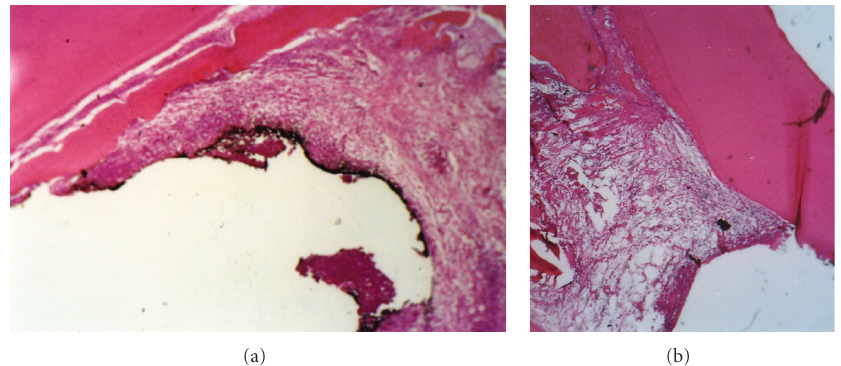
Figure 5: Periodontal tissue response in the dog following a 3- (a) or 8- (b) week application of OP-1. Note absence of inflammatory cell infiltration, traces of new bone formation, and superficial incomplete zone of mineralized matrix (magnification × 100).